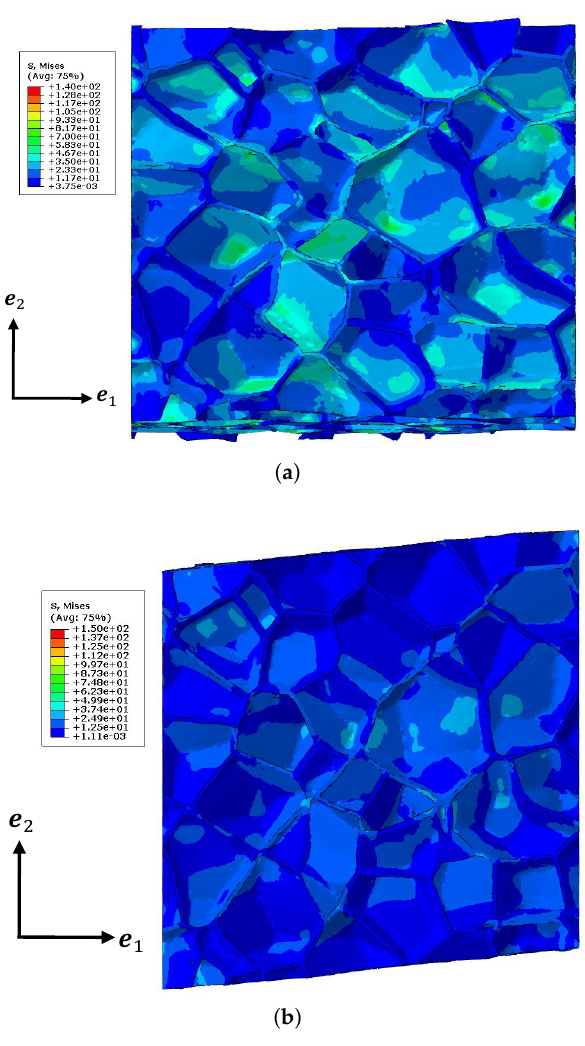
Figure 13. Deformations of the tomography model for ( a ) the tensile test and ( b ) the shear test with the von Mises equivalent stress